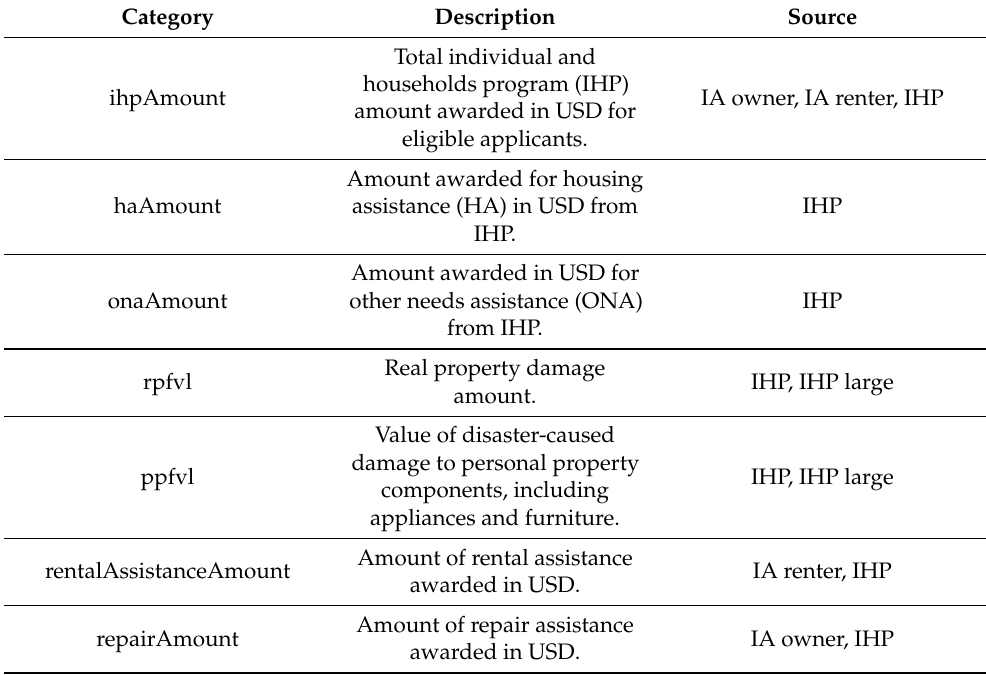
Table 2. Selected FEMA IA